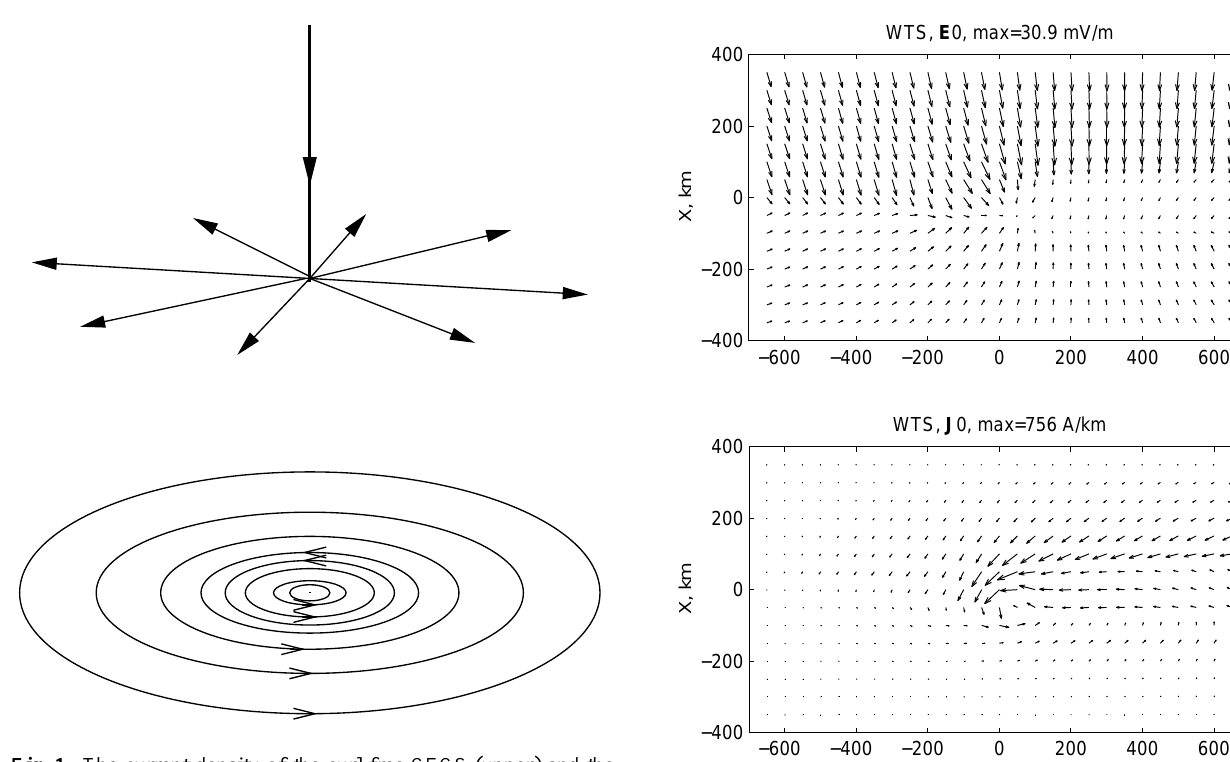
Fig. 1. The current density of the curl-free CECS (upper) and the divergence-free CECS (lower).